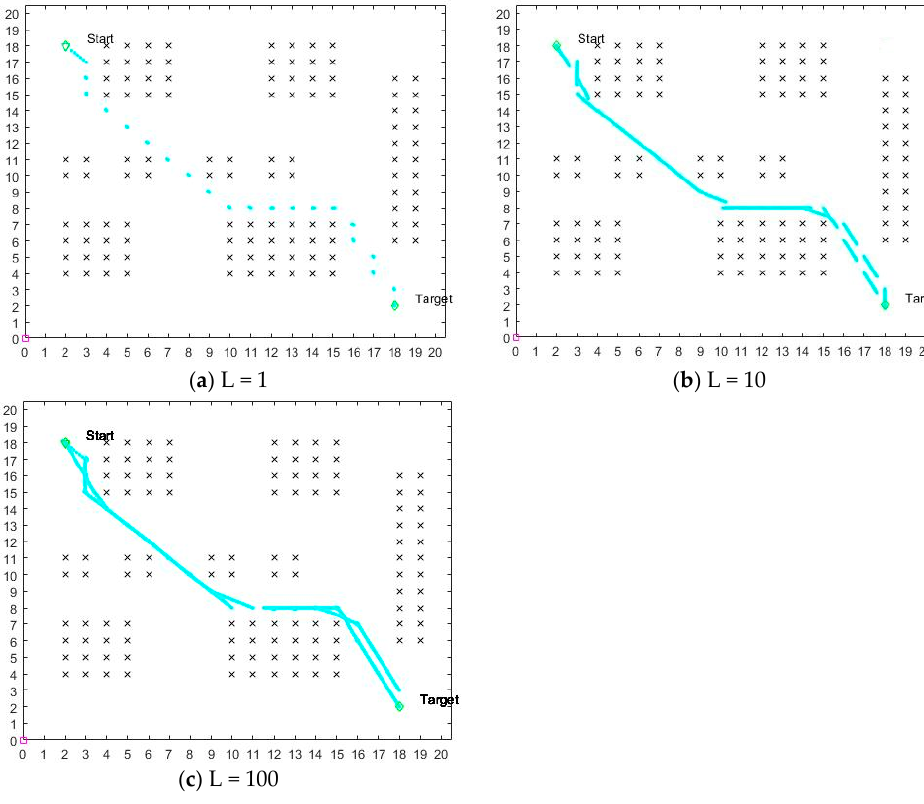
Figure 15. Effect on the optimized potential field method for different L values.